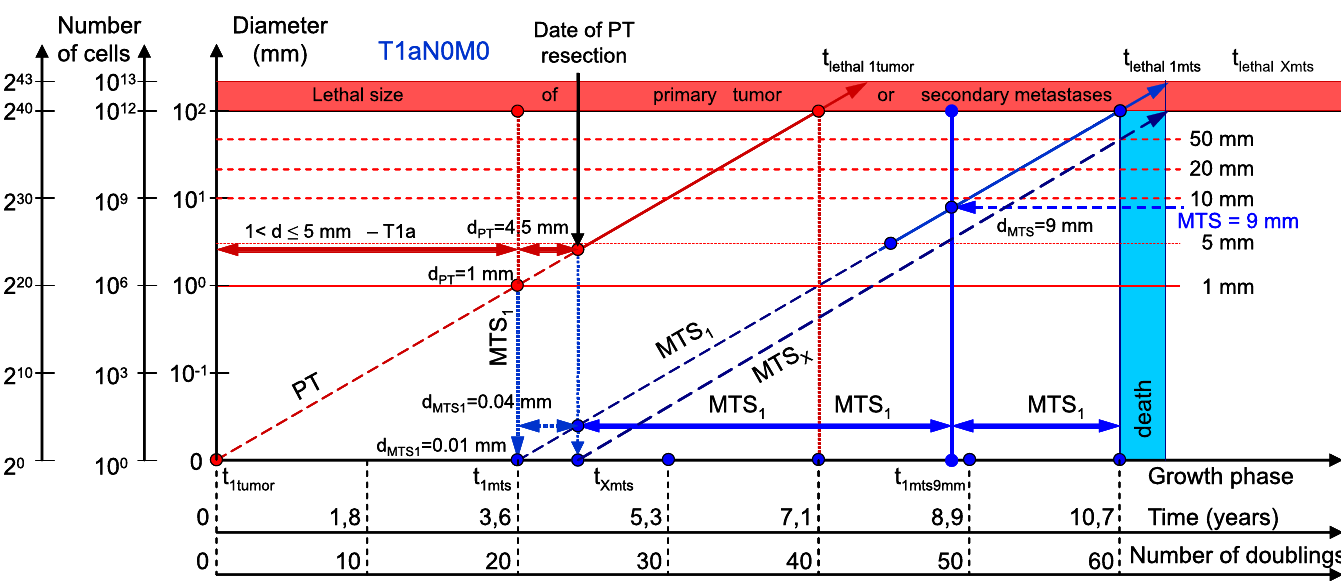
Fig 3. T1aN0M0. The whole natural history of PT and secondary distant MTS of patients without lymph nodes MTS via CoMPaS. Parameter T1a: 1 mm < d (cid:20) 5 mm. Diameter of PT at surgery of PT: d PT = 4.5 mm. Diameter of secondary distant MTS at surgery of PT: d MTS = 0.04 mm.